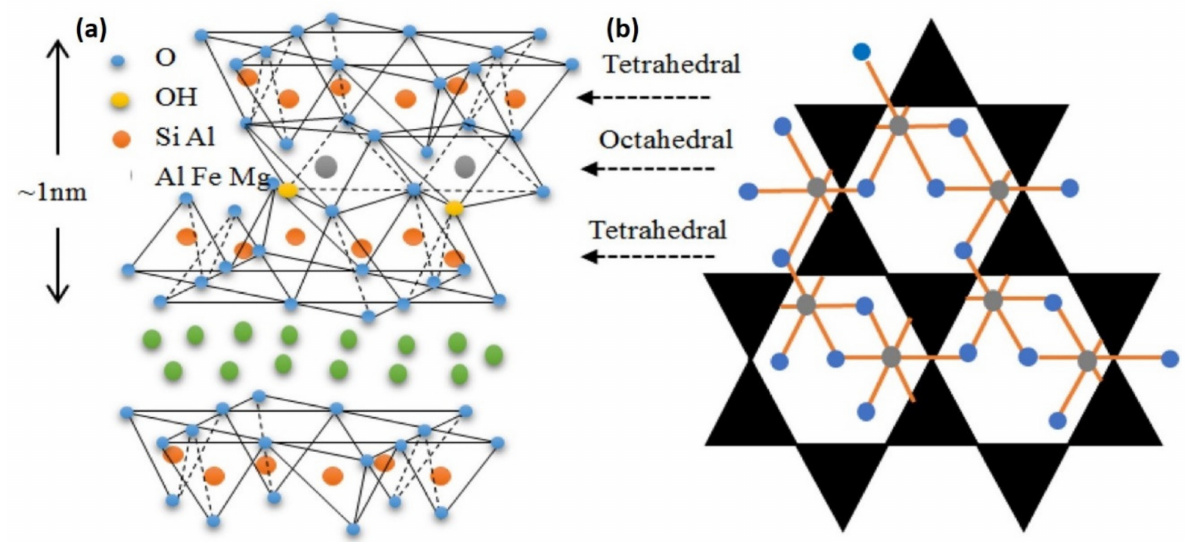
Figure 1. Schematic representation of the MMT structure. ( a ) Side view: tetrahedrons units of Mt assembled through weak van der Waals and electrostatic forces to form the primary particles, and ( b ) top view: hexagonal structure of oxygen and hydroxyl ligands of the octahedral layer. Reproduced from [63].